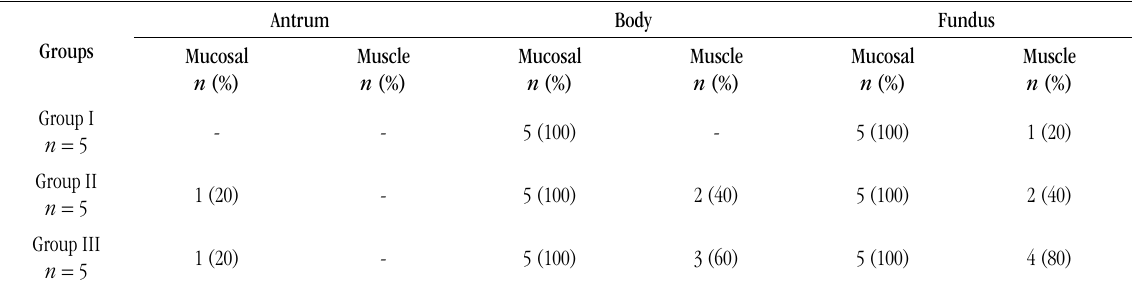
tABLE 2 – Microscopic changes of the rabbit stomach indicative of hemorrhagic necrosis in the mucosal and muscle layers of the antrum, body and fundus regions after 3, 6 and 12 hours of gastric ischemia (groups I, II and III, respectively) Antrum Body Groups